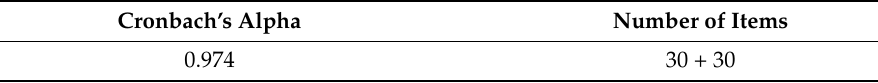
Table 4. Reliability statistics.